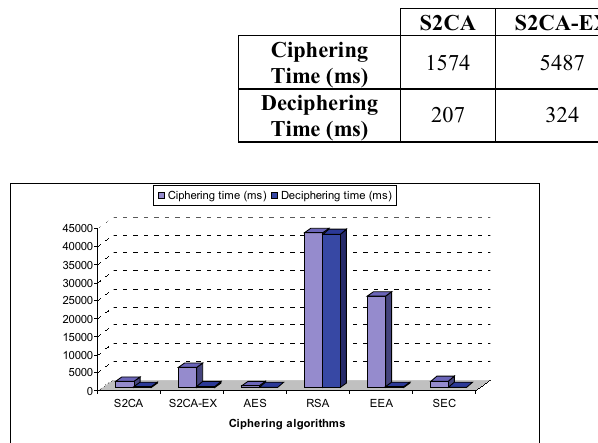
Table 7. Ciphering and deciphering time of S2CA and S2CA-EX compared to the main ciphering standards.